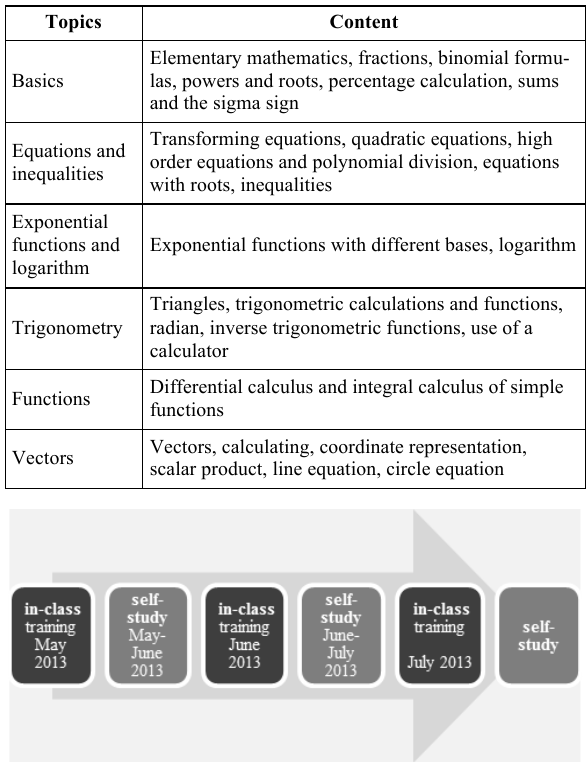
Figure 2. Alternating phases in the blended-learning concept of the preparatory mathematics course Germany, not just from Aschaffenburg and its